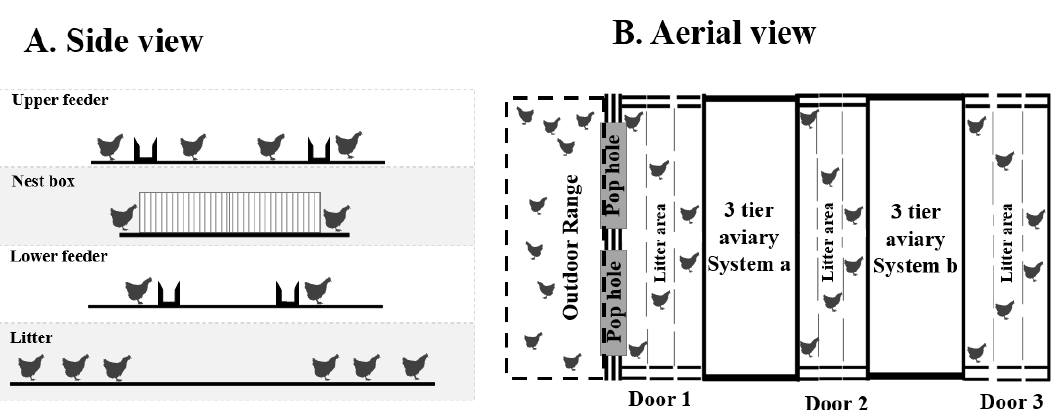
Figure 2. Pictorial diagram of locations that hens were randomly selected from within the commercial 3-tiered aviary system. ( A ) represents a side view and ( B ) represents an aerial view of the aviary system showing the floor area with litter, lower feeder tier, nest box tier and the upper feeder tier as well as the outdoor range. Hens could freely access any area according to their choice, except when the pop holes to the range were closed during 8 pm until 4 am. For the random hen selection for behavior tests at 74 weeks of age, each location was allocated a random number and the order of locations were determined using a random sequence generator (https: // www.random.org / sequences / ) corresponding to the allocated location number. Thus, the randomly created sequence was used to select hens from all sections of the aviary. The pen had three entry doors (B. aerial view) which were entered